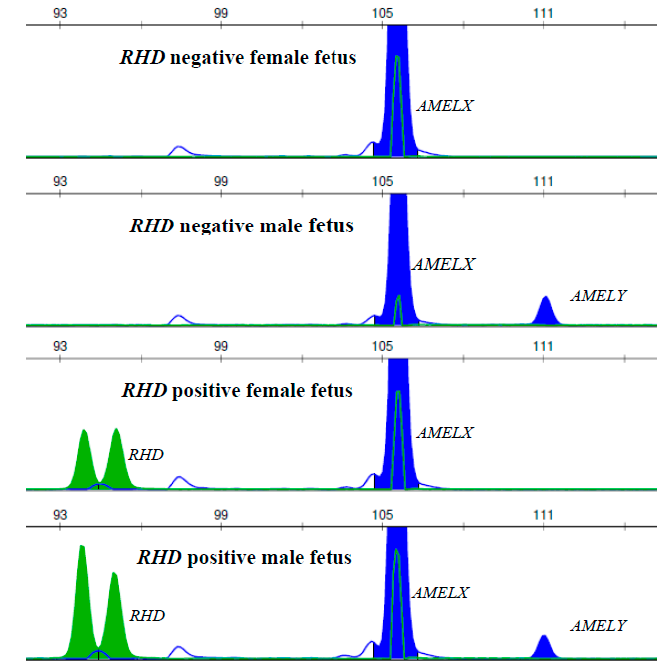
Figure 2. Example of the determination of RHD -positive and RhD-negative status and sex of the fetus using endpoint PCR with capillary electrophoresis. The RFU (relative fluorescence unit) parameter is expressed by green peak heights of RHD exon 7 and by blue peak heights of AMELX/Y gonosomal sequences (internal amplification controls).